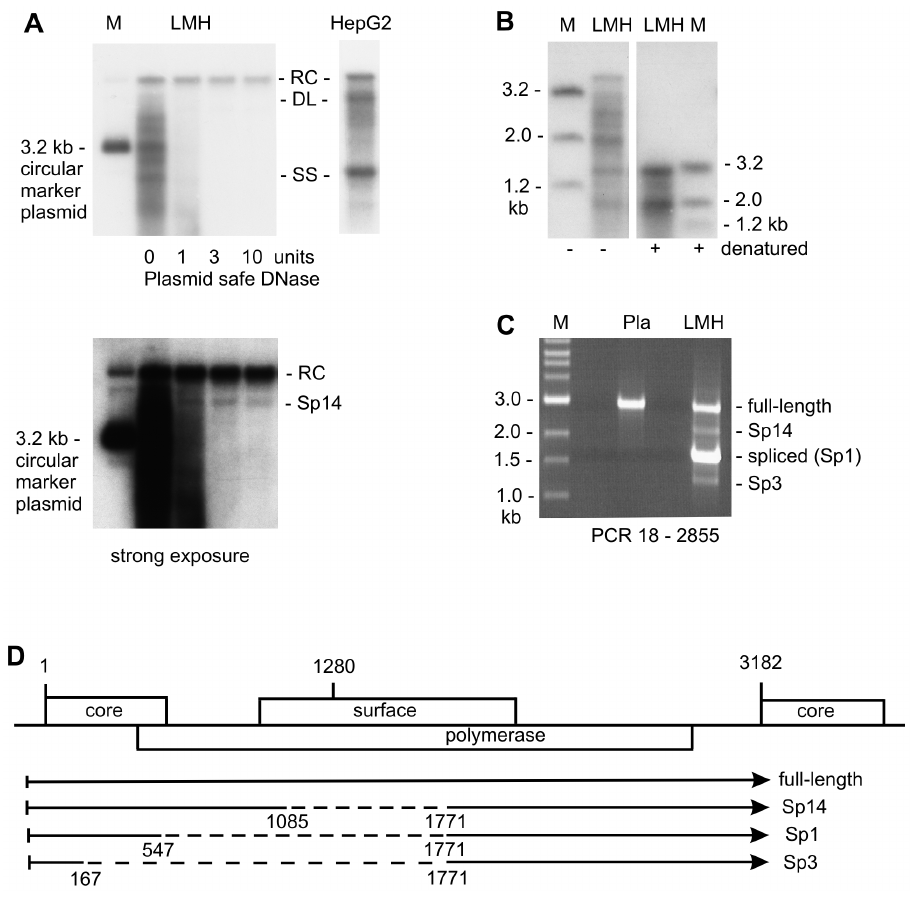
Figure 1. Identification of spliced HBV genomes in transfected LMH cells. The plasmid transfected is coding for wild type HBV with the natural core promoter driving transcription of pgRNA. Viral DNA was prepared from cell cytoplasm that was treated with micrococcal nuclease to remove the transfected plasmid. ( A ) Viral DNA from transfected LMH cells was incubated with increasing amounts of Plasmid safe DNase and visualized by Southern blot analysis using a 32 P-labelled probe covering both strands of the whole HBV genome. A circular 3.2 kb plasmid, which migrates at the position of cccDNA, served as marker (M). Positions of relaxed circular (RC), double strand linear (DL) and single stranded (SS) viral DNA are indicated. Viral DNA from cytoplasm of transfected HepG2 cells is shown as reference. The lower panel is a strong exposure of the blot to visualize the Sp14 spliced DNA which is resistant to Plasmid safe DNase digestion. ( B ) Viral DNA from transfected LMH cells and linear marker fragments were denatured by heating before gel electrophoresis. The left panel shows non-denatured DNA for comparison. The positions of linear size marker (M) fragments are indicated. ( C ) Viral DNA was amplified with primers binding at genome position 18 and 2855 relative to the core start codon. Plasmid (Pla) containing the full-length HBV genome served as reference template. Amplification products derived from full-length HBV genome and the predominant spliced species (Sp1) are indicated. Less prominent amplification products, representing Sp3 and Sp14 spliced species, are also indicated. ( D ) The diagram shows a map of the HBV genome with the core, polymerase and surface coding sequences drawn as rectangles. The core gene is presented twice to indicate that the viral genome has a circular structure. The start codon of the core protein coding gene is position 1 in the here applied nomenclature with the whole HBV genome consisting of 3182 nucleotides. At genome position 1280, there is an Eco RI restriction site, which serves as point of reference in other commonly applied nomenclature. Arrows below symbolize spliced and full-length pgRNA. The dashed lines illustrate the intron sequences that are removed in Sp14, Sp1 and Sp3 spliced species. The corresponding splice donor sites are at position 167, 547 and 1085 while the common splice acceptor site is at position 1771. If numbering starts with the Eco RI restriction site, the common splice acceptor site will be position 487 and the splice donor sites will be position 2065, 2445 and 2983, according to Abraham et al. ,